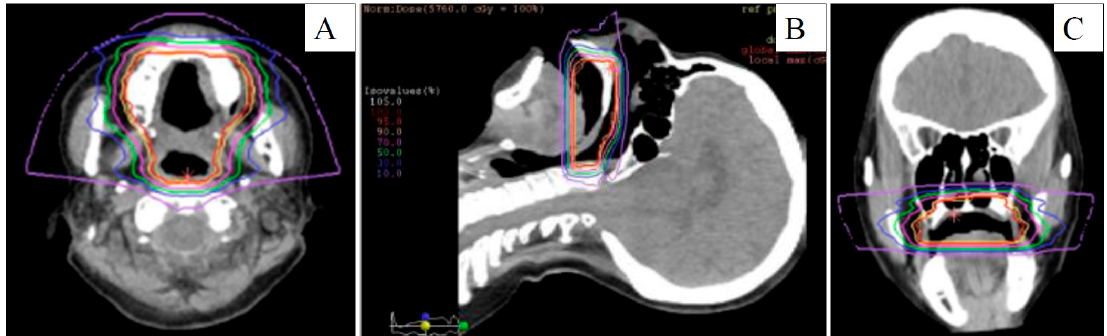
Figure 2. Computed tomography for carbon-ion dose distribution in initial mucosal melanoma. ( A ) Axial, ( B ) sagittal, and ( C ) coronal views. 70% dose: red-purple line, 50% dose: blue line, and purple line: 10%.